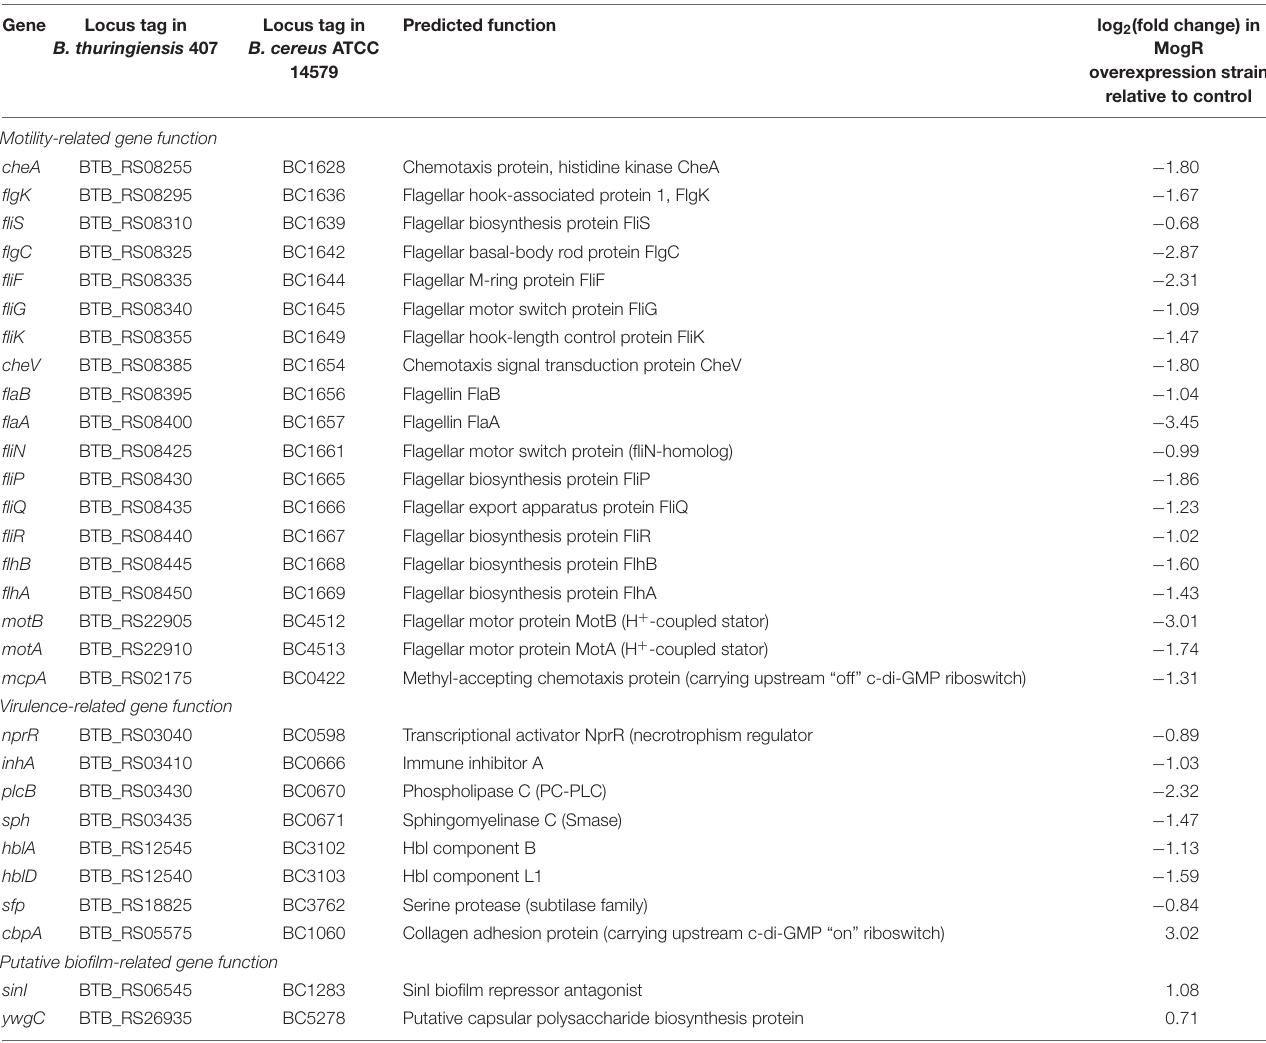
TABLE 2 | Genome-wide gene expression analysis of B. thuringiensis 407 overexpressing MogR relative to an empty vector control strain using oligonucleotide microarrays. Gene Locus tag in Locus tag in Predicted function log 2 (fold change) in B. thuringiensis 407 B. cereus ATCC 14579